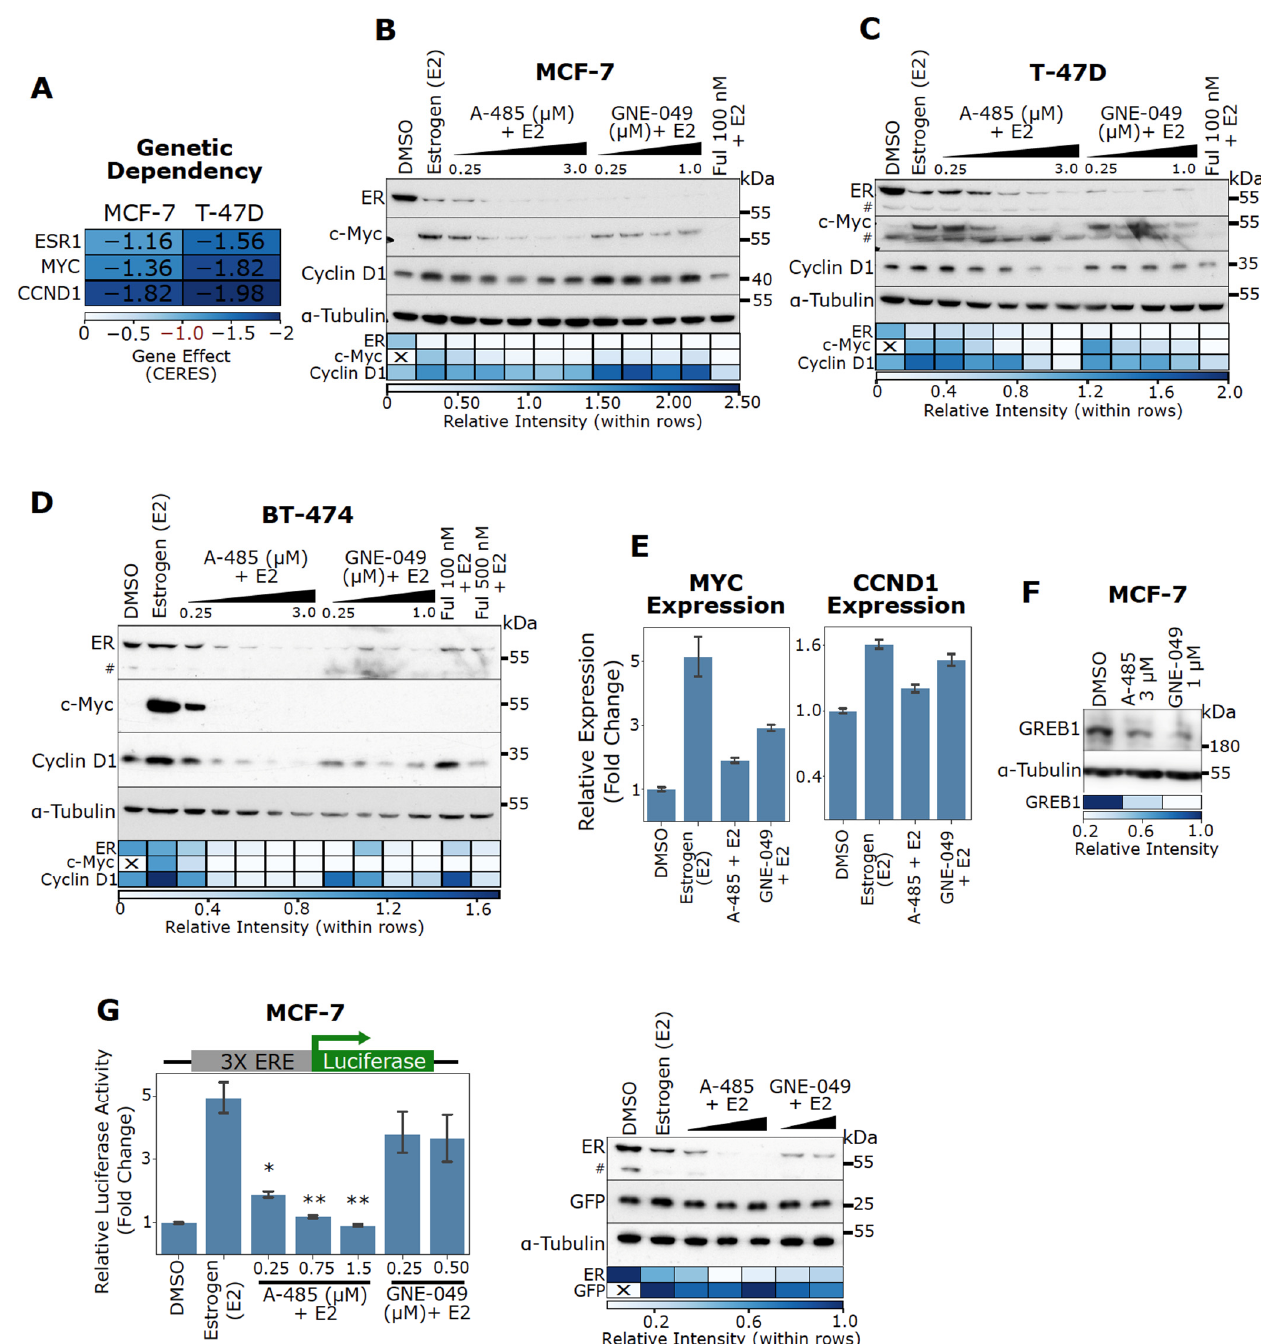
Figure 2. CBP/p300 KAT inhibitor A-485 and BD inhibitor GNE-049 downregulate ER protein levels and antagonize E2-stimulated activation of ER target genes MYC and CCND1. ( A ) ESR1, MYC, and CCND1 are essential in ER+ BC cells as determined by the Cancer Dependency Map. A Gene Effect of 0 is the median nonessential KO effect and -1 is the median essential KO effect. ( B – D ) CBP/p300 inhibitors potently reduce ER protein levels and antagonize E2-induced c-Myc expression in MCF-7 ( B ), T-47D ( C ), and BT-474 ( D ) cells. Cells were cultured in complete CSS medium, and then exposed to A-485 and GNE-049 for 24 h and E2 (1 nM) was added 6 h before cell lysis. ER, c-Myc and Cyclin D1 protein levels were assessed via immunoblotting. Densitometry quantification of the immunoblot bands are depicted below via heatmap. ( E ) Representative qPCR results for MYC and CCND1 expression in MCF-7 cells treated with E2 (1 nM), A-485 (750 nM), GNE-049 (250 nM) or their combination. Cells were cultured in complete CSS media and treated with CBP/p300 inhibitors for 24 h. E2 was added 4 h before lysis. Representative results of n = 2. Errors bars are SEM of two technical replicates. ( F ) A-485 and GNE-049 reduce GREB1 expression. MCF-7 cells were treated with A-485 and GNE-049 for 24 h